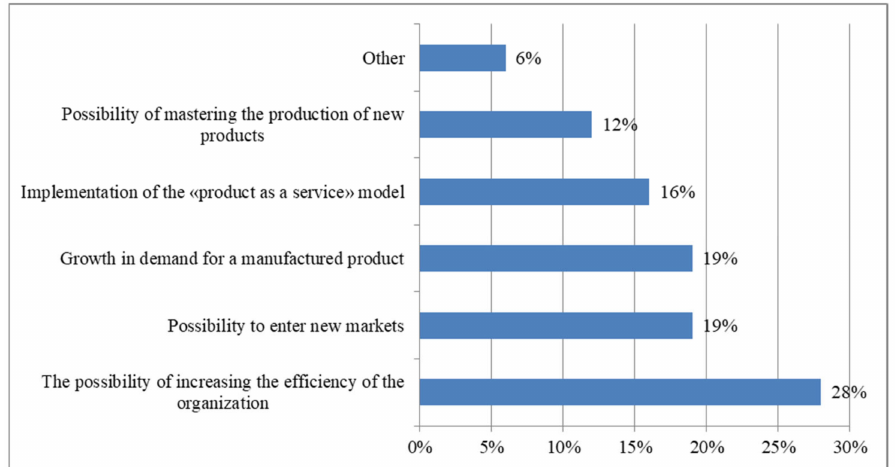
Figure 12. Emerging new opportunities in digital transformations at manufacturing enterprises of the Republic of